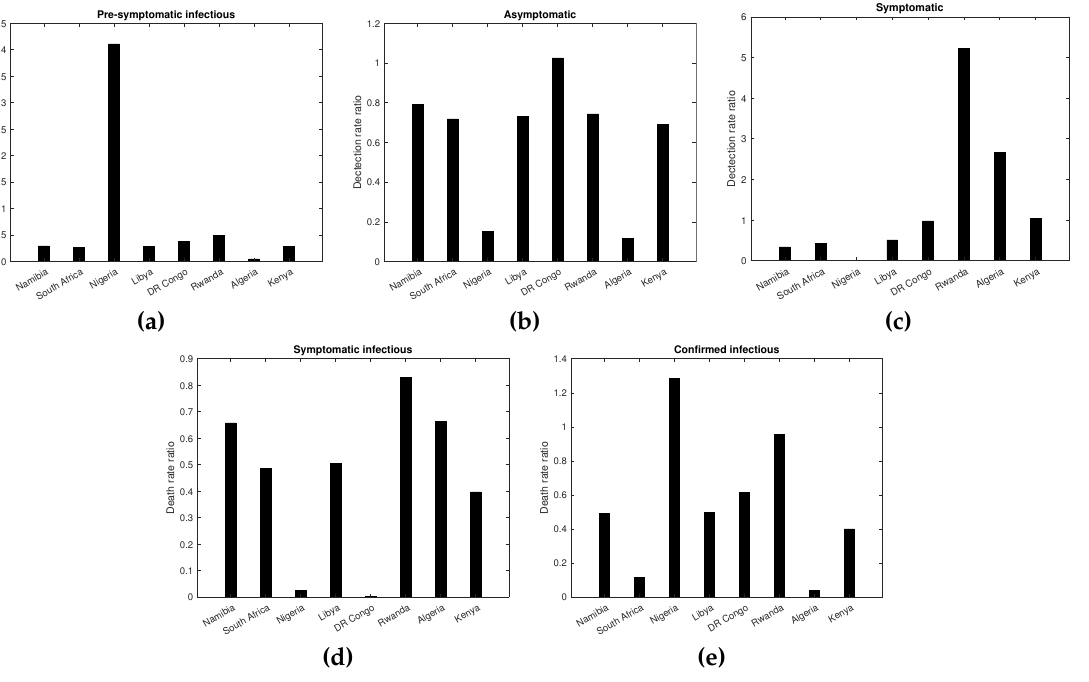
Figure 3. Vaccine effectiveness against COVID-19 infections and deaths. Panels ( a–c ) depict vaccine effectiveness against pre-symptomatic, asymptomatic, and symptomatic new infections Panels ( d,e ) present vaccine effectiveness against symptomatic and confirmed